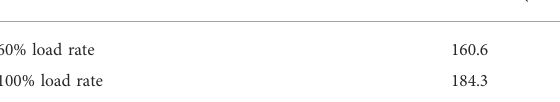
TABLE 3 The core grounding current when the load factor of the converter transformer is 60% and